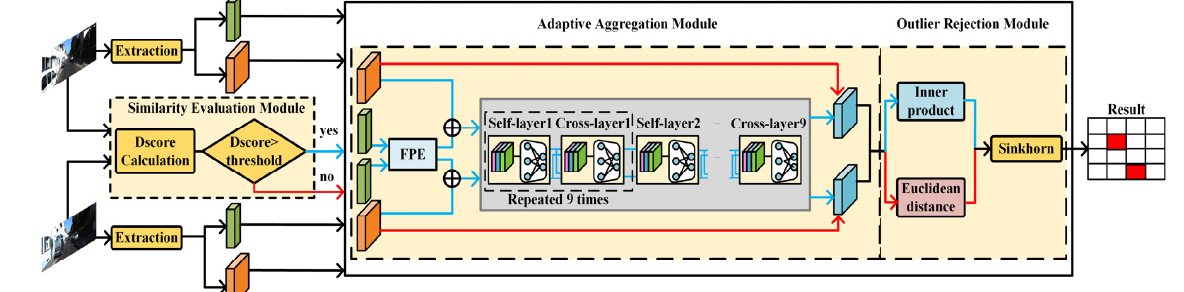
Figure 3. The architecture of the proposed AdaSG. Red lines represent the E-mode dataflow and blue lines represent the D-mode dataflow. Self-layering and cross-layering were repeated nine times alternatively.